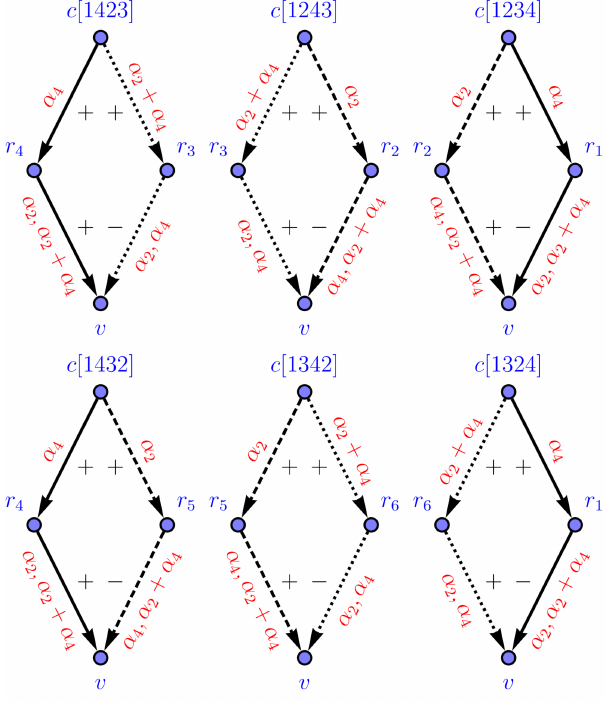
Figure 13 . Complete paths for n = 4 and the minimal collection of labels which identify them. variety defined by l (1) = · · · = l ( d − 1) = 0 , which passes through the